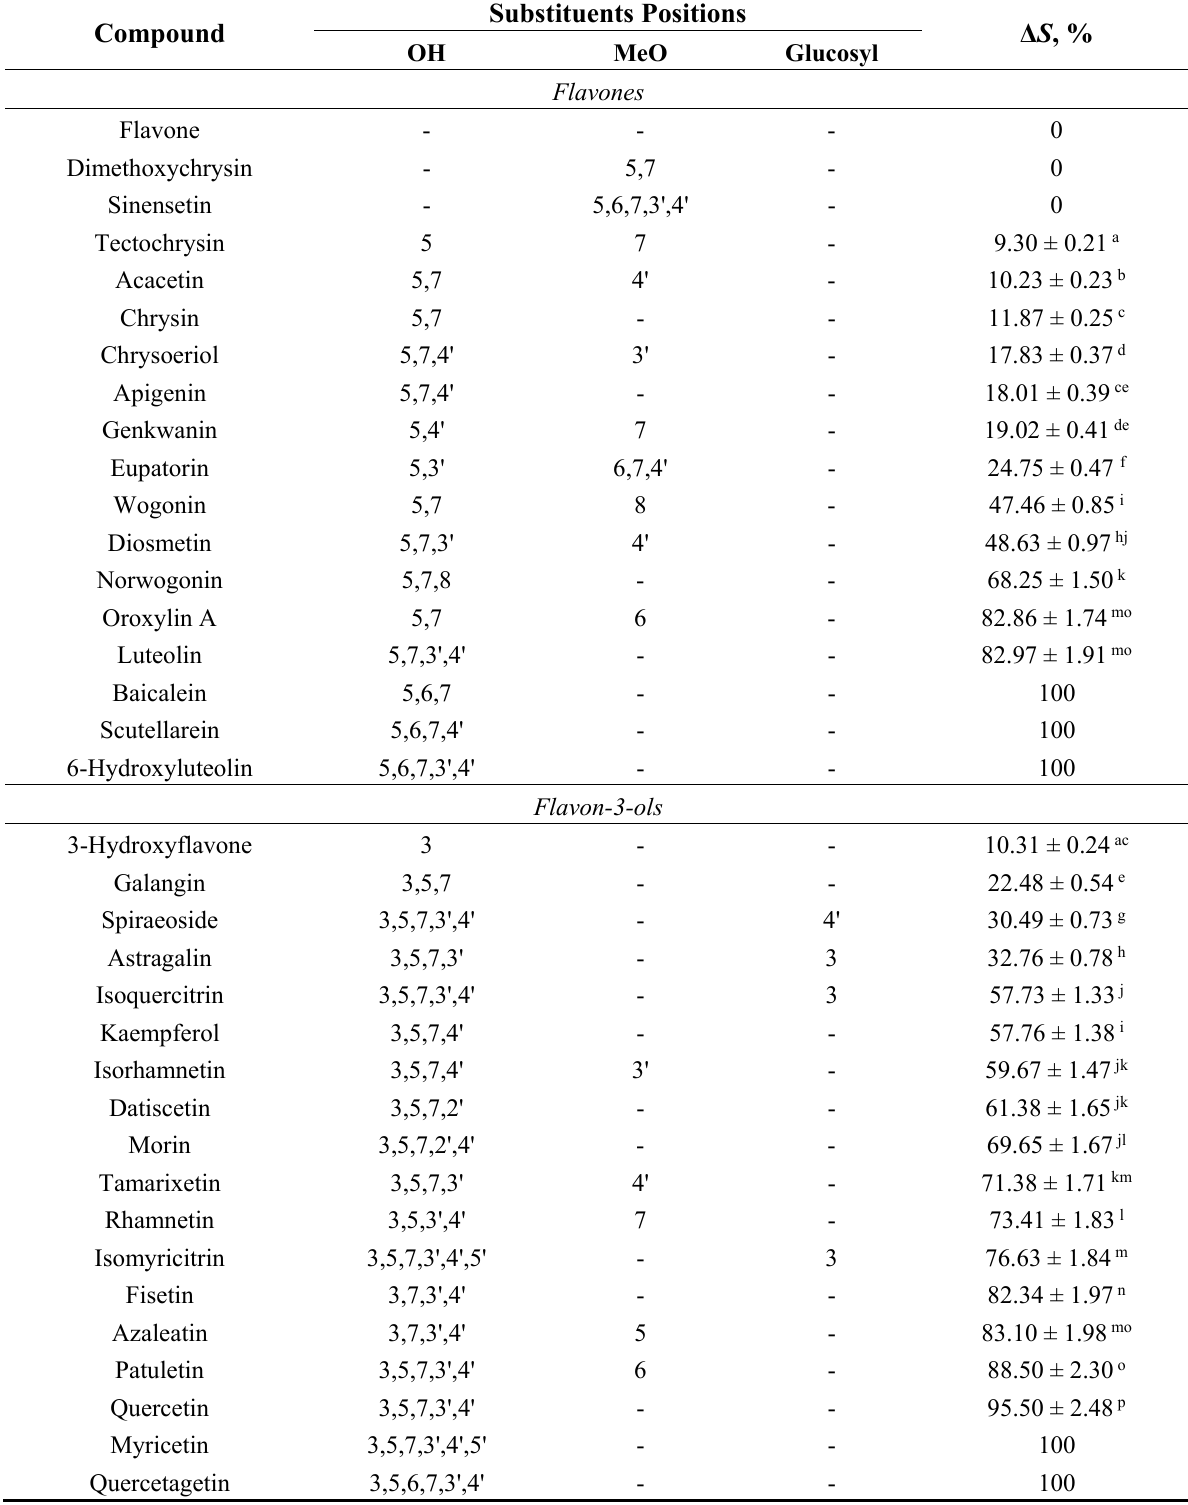
Table 1. Reduction of peak areas ( Δ S ) of flavones and flavonols after prechromatographic reaction with Fe 2+